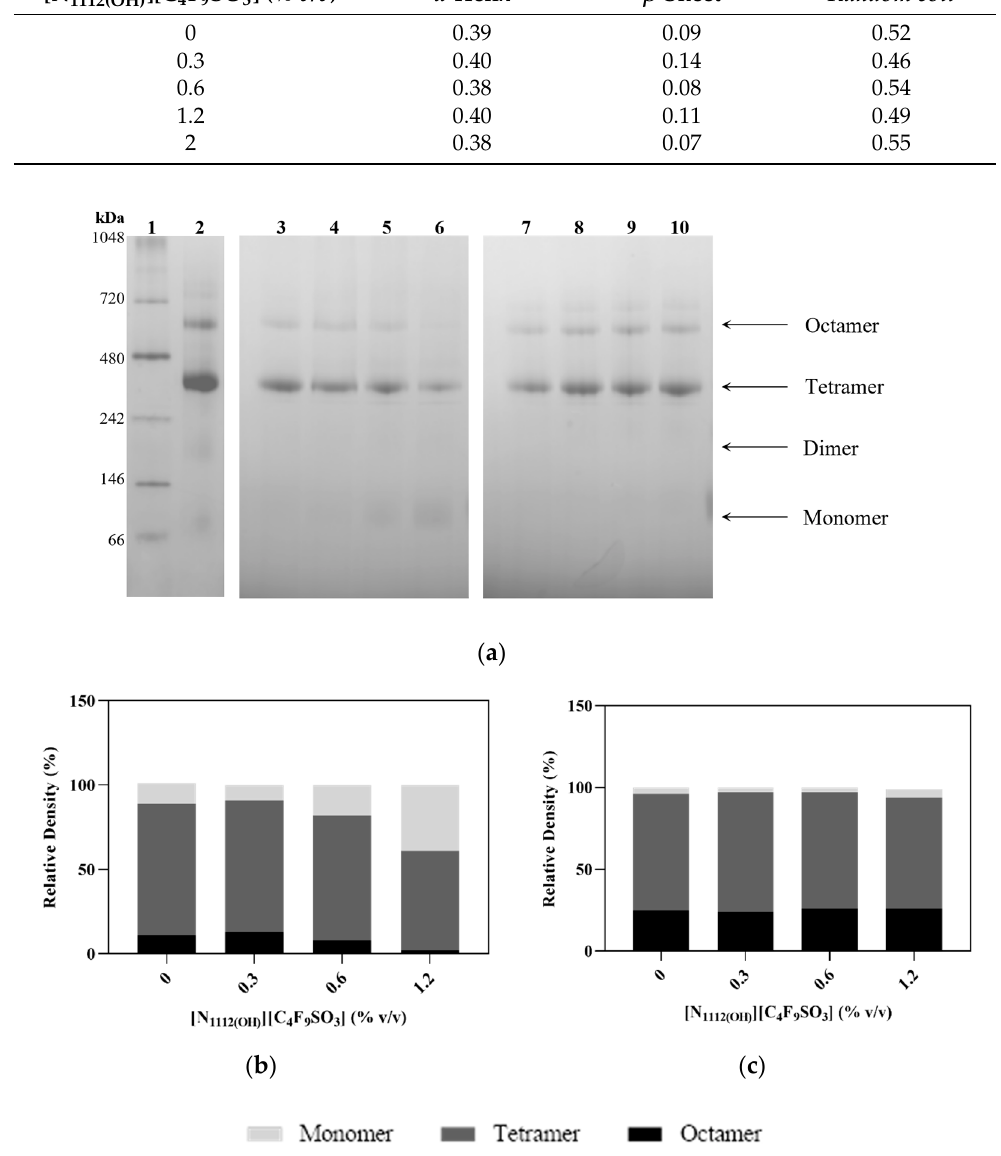
Figure 6. Oligomerization states of hPAH. ( a ) Blue native electrophoresis. Gel 1 (reference): Lane 1–NativeMark; Lane 2—hPAH; Gel 2 (no L-Phe): Lane 3—hPAH, Lane 4—hPAH + 0.3% FIL; Lane 5—hPAH + 0.6% FIL; Lane 6—hPAH + 1.2% FIL; Gel 3 (L-Phe): Lane 7—hPAH + L-Phe, Lane 8—hPAH + L-Phe + 0.3% FIL; Lane 9—hPAH + L-Phe + 0.6% FIL; Lane 10—hPAH + L-Phe + 1.2% FIL. Relative quantification of ( b ) hPAH + FIL and of ( c ) hPAH + L-Phe + FIL calculated using ImageJ software, considering, respectively, Lanes 3 and 7 as controls.